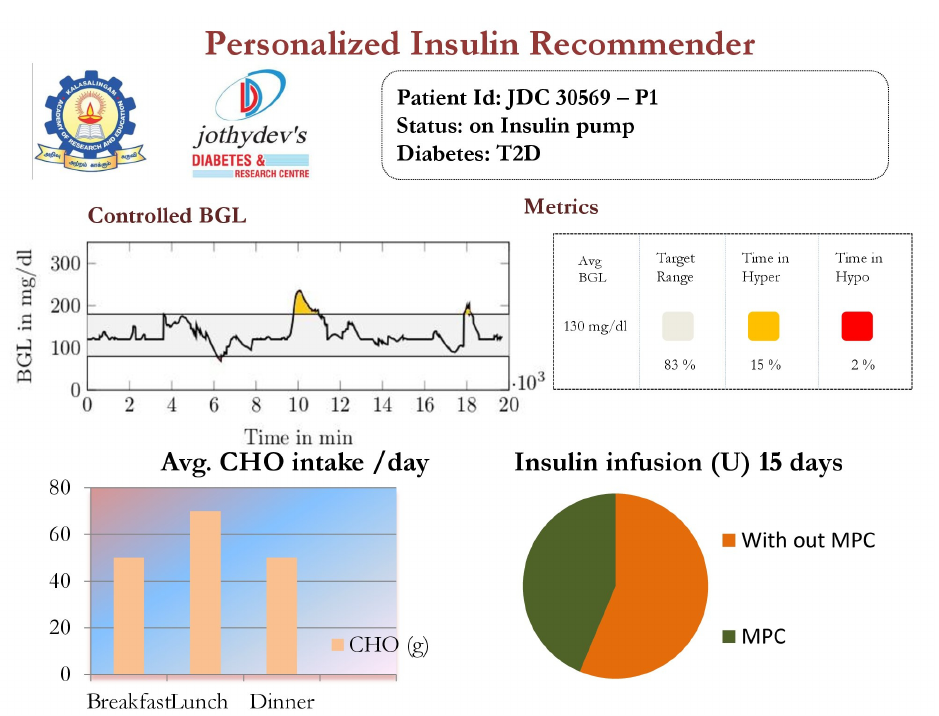
Figure 4. Simulated web page view of the patient’s data.